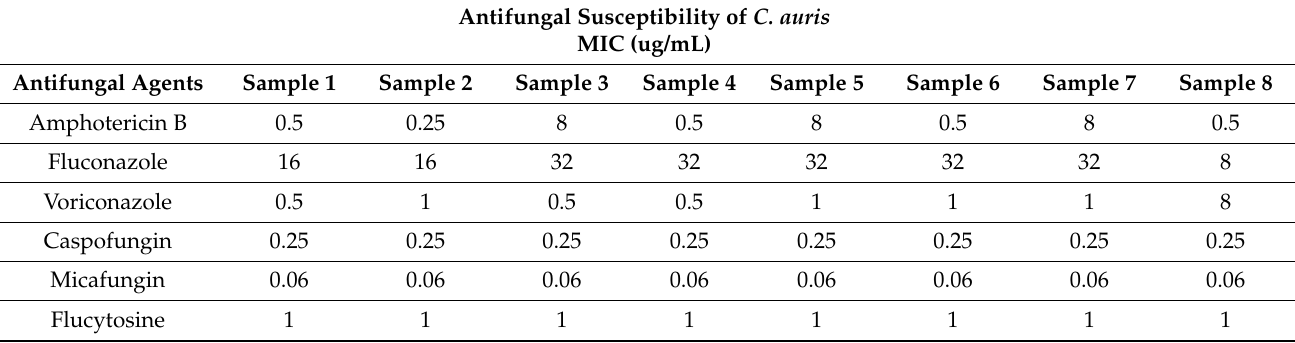
Table 1. Antifungal susceptibility testing of C. auris